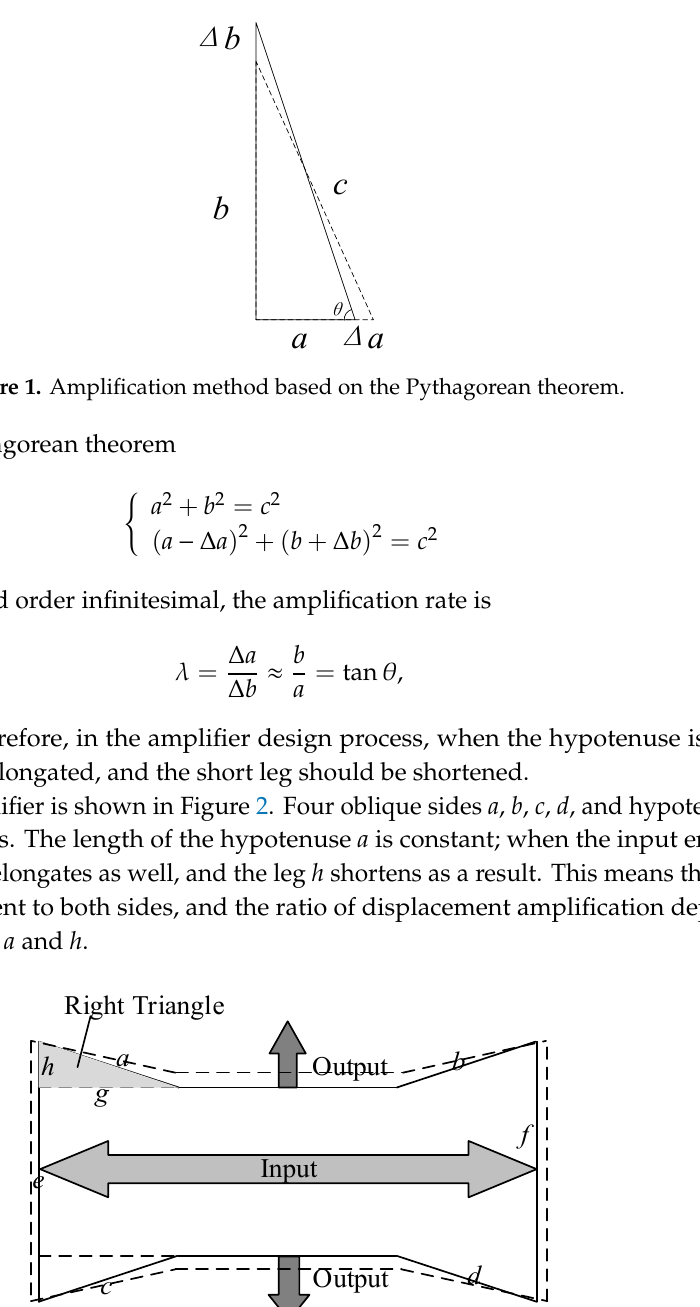
Figure 2. Simplified diagram of a bow-type amplifier.